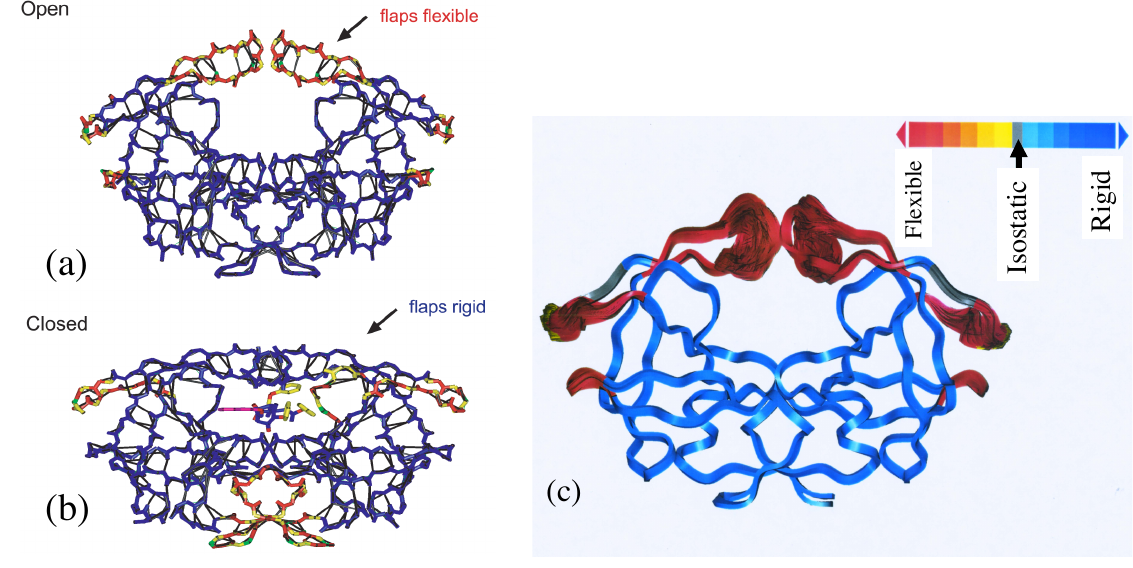
Figure 60. Two configurations of the HIV Protease protein ( a ) open and ( b ) closed with a docked drug. In ( c ) we see a simulation of the flexibility of the open form, extracted from the rigidity and flexibility in ( a ) which the drug will inhibit (rigid in ( b )). Basic ptrotein figures produced by the groups of Professors Mike Thorpe and Leslie Kuhn